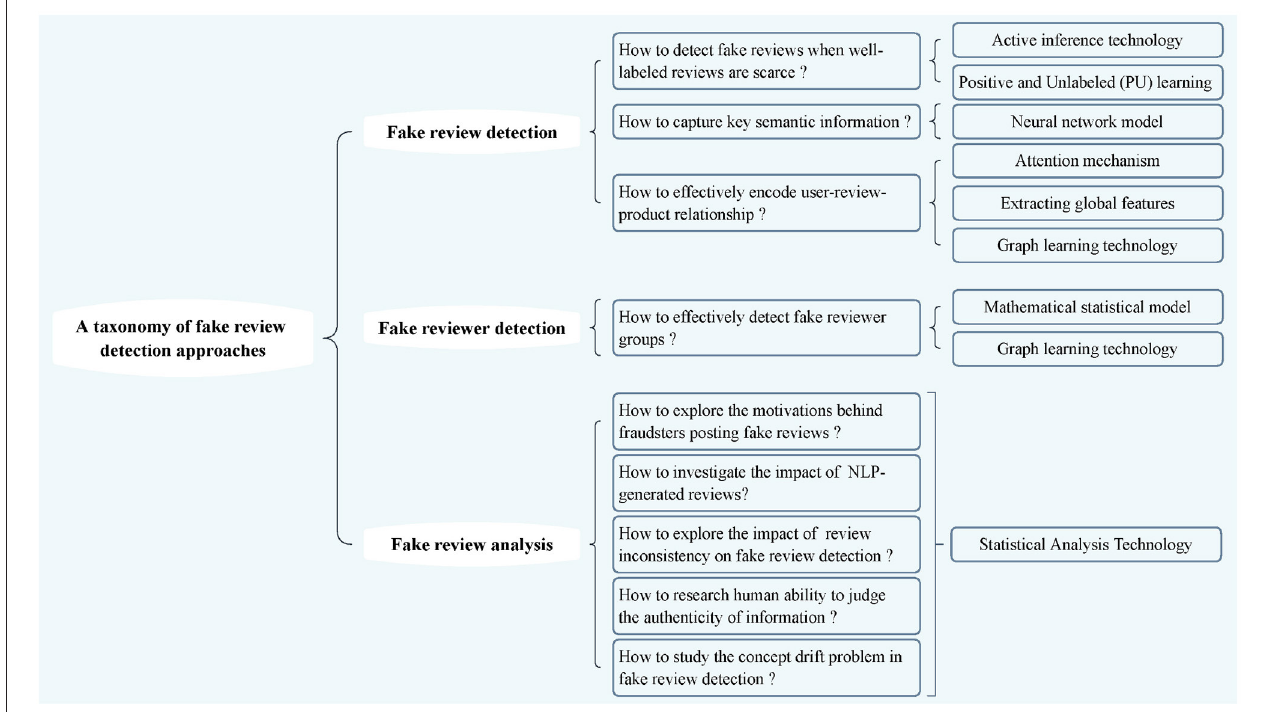
FIGURE 2 | A taxonomy of fake review detection